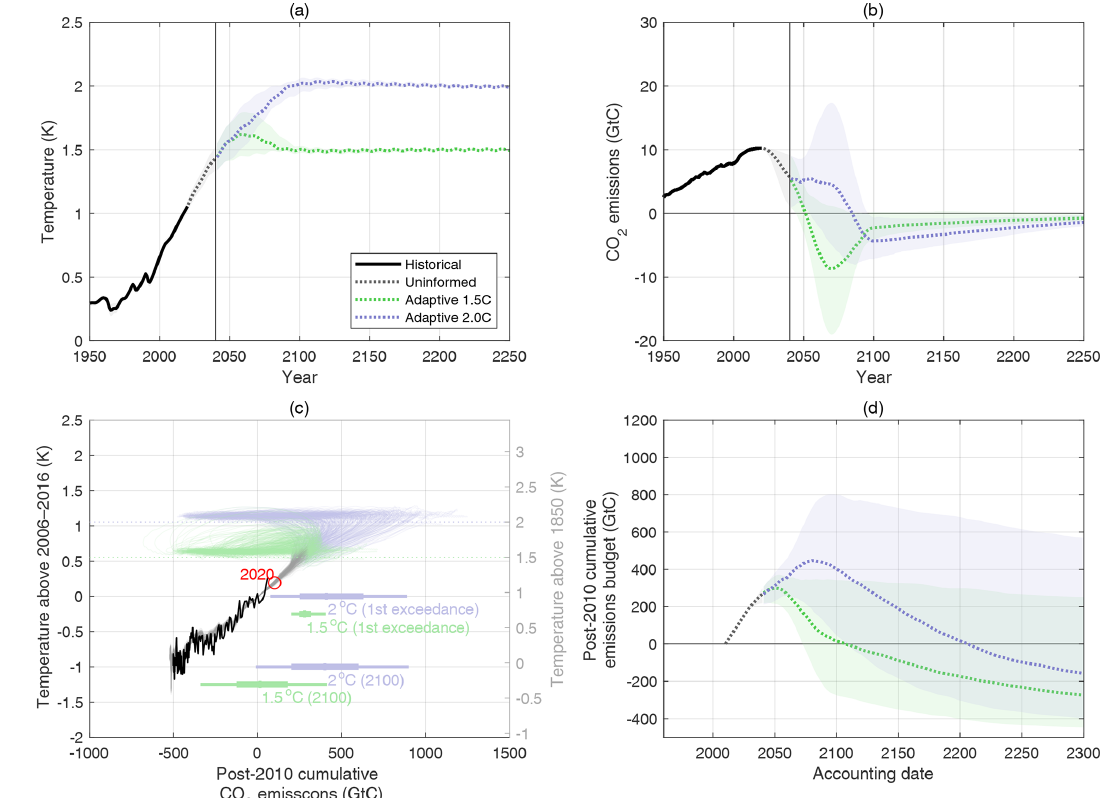
Figure 2. Plots showing idealized pathways to 1.5 or 2.0 ◦ C temperature stabilization for an ensemble of coupled carbon–climate model configurations. Panel (a) shows the global mean temperature as a function of time for 1.5 and 2.0 ◦ C stabilization ensembles; (b) shows emissions in the historical, uniformed and adaptive stages of the simulation; (c) shows the global mean temperatures above 2006–2016 (left/right axis) levels as a function of post-2010 cumulative CO 2 emissions, while (d) shows the cumulative carbon emissions total for ensemble members as a function of time. Shaded regions in (a, b, d) indicate 10th–90th percentile range of the ensemble distribution, while dotted lines shown the 50th percentile. Gray/blue/black areas refer to uninformed/adaptive for 2.0 ◦ C/adaptive for 1.5 ◦ C respectively. Box– whisker plots in (c) show the long-term cumulative carbon budget assessed in 2100 for 1.5 and 2.0 ◦ C stabilization from 1850 to 2500. Box–whisker plots in (d) show the TCRE estimate of carbon budget with (median shown by “ + ”) and without (median shown by “x”) non-CO 2 gas correction. Red circle shows ensemble mean warming and post-2010 cumulative emissions in